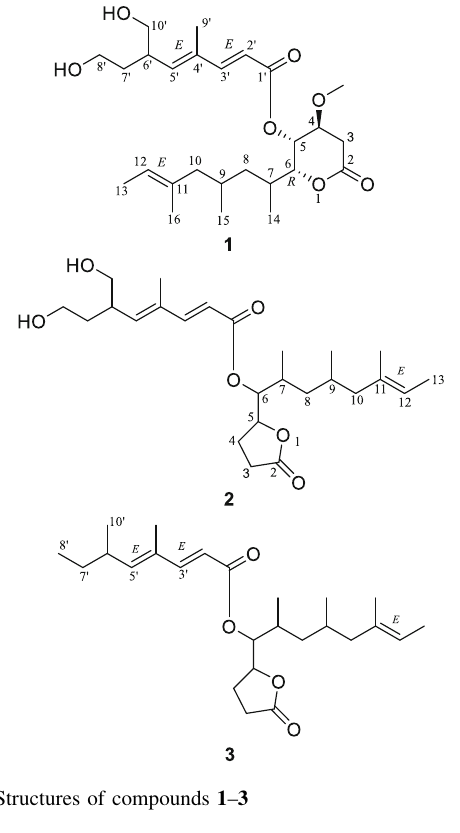
Fig. 1 Structures of compounds 1 –